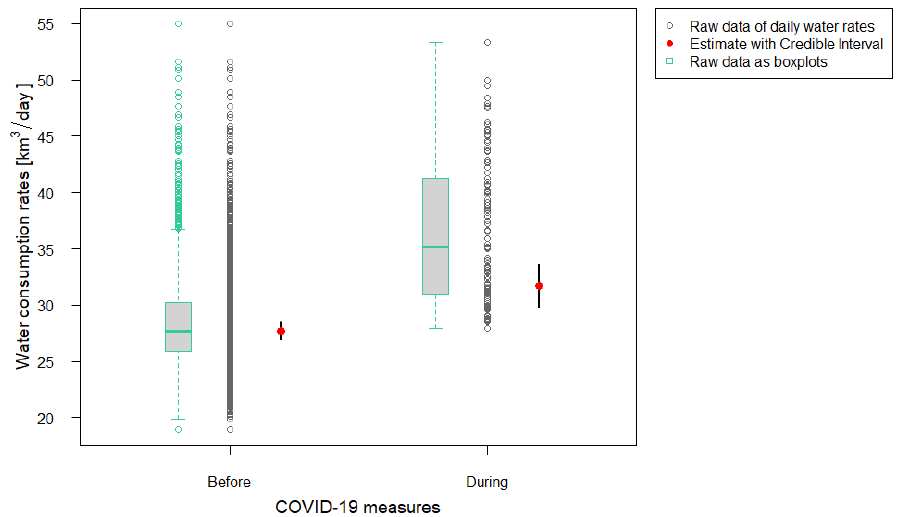
Figure 3. Daily water consumption volumes before and during strict Corona measures. Fitted values (red circle), predicted from the linear mixed model, with 95% credible intervals are given assuming average values for all other independent variables. N Before = 1470 days (2006–2019 each 03/16–06/28); N During = 105 days (03/16/2020–06/28/2020).